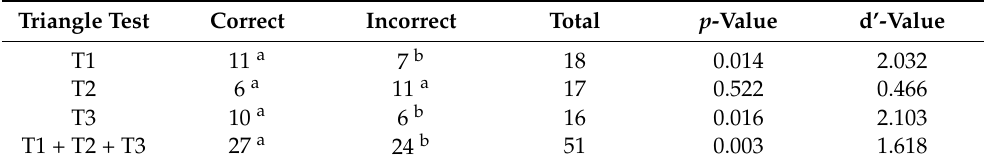
Table 1. Correct and total results of triangle tests (including statistical p - and d’-values) for the 70% dark chocolate samples produced from convectively roasted (convectively: 130 °C–30 min) and microwave roasted (microwave: 600 W–35 min) cocoa beans performed in three different sessions (T1 = first session, T2 = second session, T3 = third session).